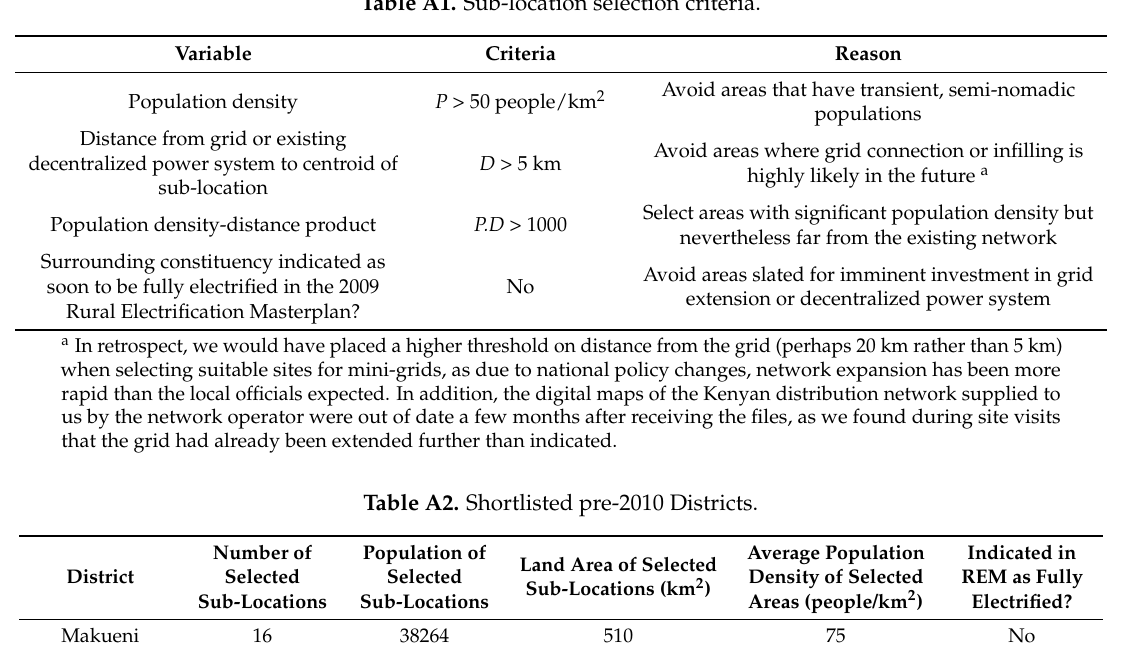
Table A1. Sub-location selection criteria.